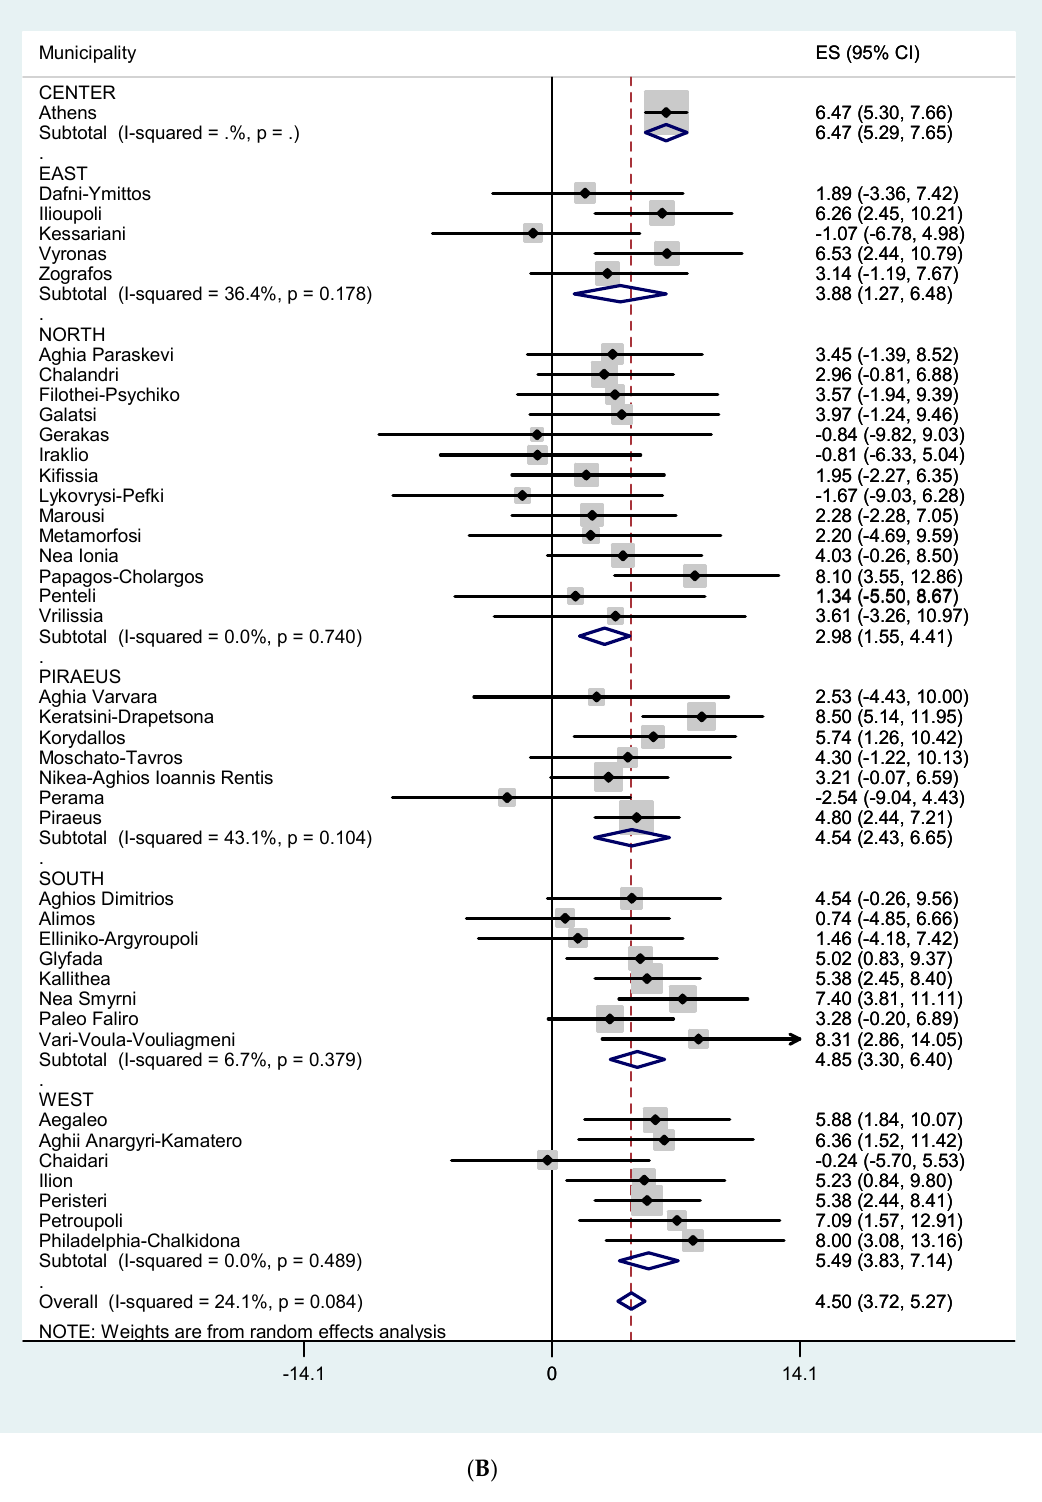
Figure 4. ( A ) % increase in cardiovascular mortality, all ages, per 1 °C increase in maximum temperature in each municipality, using Thissio measurements and threshold of 31.5 °C. ( B ) % increase in cardiovascular mortality among the elderly (75+) per 1°C increase in maximum temperature in each municipality, using Thissio measurements and threshold of 31.5 °C.